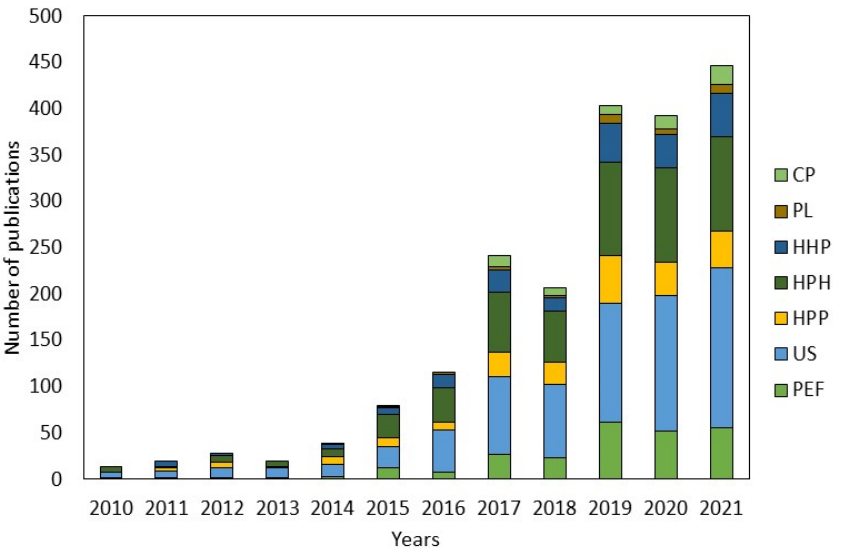
Figure 1. Number of publications about the effect of non-thermal processing technologies on bioac- cessibility. CP: Cold plasma; PL: Pulsed light; HHP: High hydrostatic pressure; HPH: High pressure homogenization; HPP: High pressure processing; US: Ultrasounds; PEF: Pulsed electric fields.